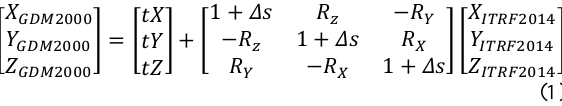
Figure 1 . General flow-chart of methodology.